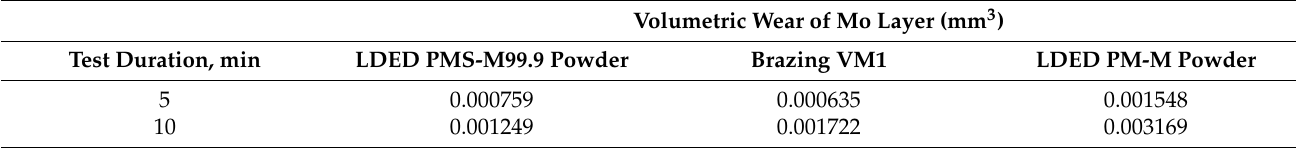
Figure 17. The dependence of the volume of material removed from the wear time. Table 8. Volumetric wear values of Mo layer after abrasive wear tests.